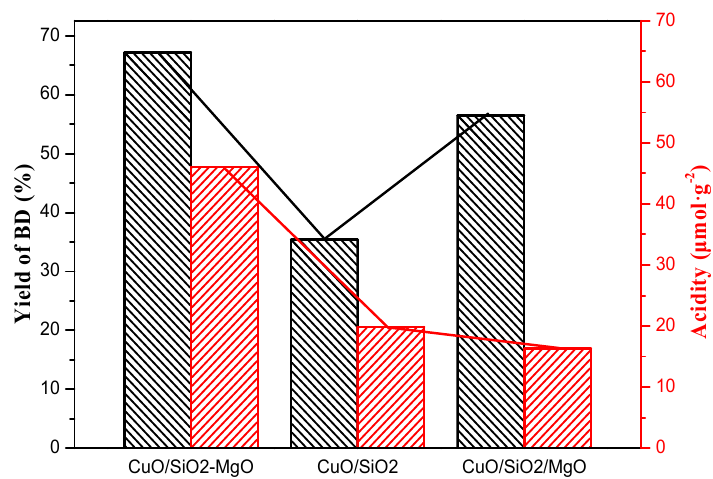
Figure 17. Relationship between BD yield and Lewis acid sites.